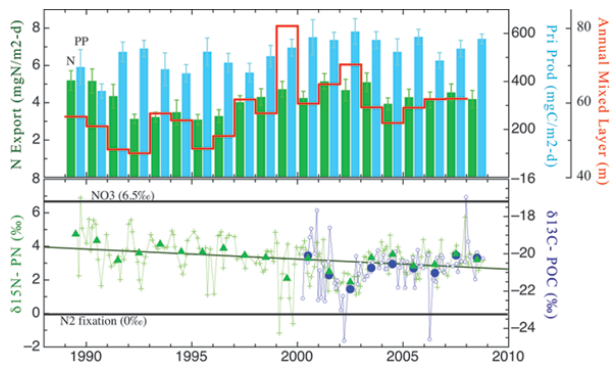
Fig. 1. Composite HOT-ALOHA data (http://hahana.soest.hawaii. edu/hot/hot-dogs/) including (upper panel) nitrogen export, primary productivity, annual mixed-layer depth and (lower panel) δ 15 N and δ 13 C of sinking